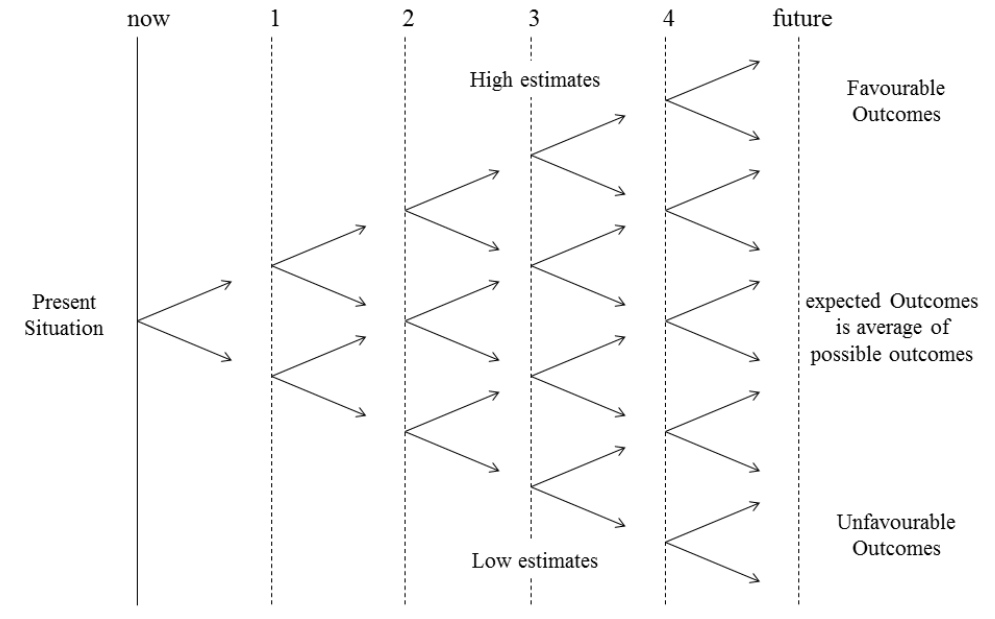
Figure 6. Binomial